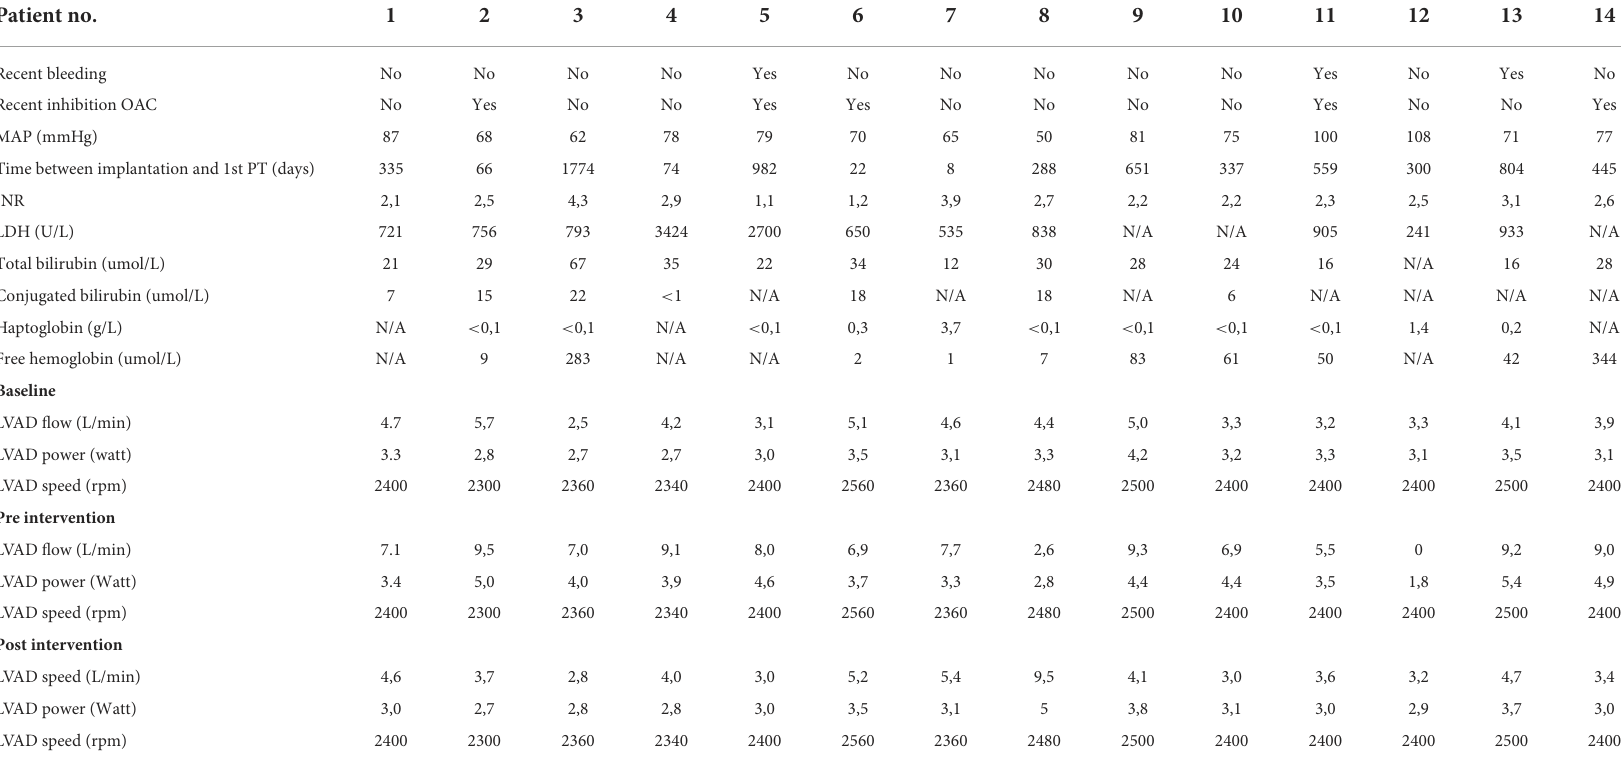
TABLE 2 Risk factors for pump thrombosis, laboratory values at the time of pump thrombosis and LVAD values peri-intervention. Patient